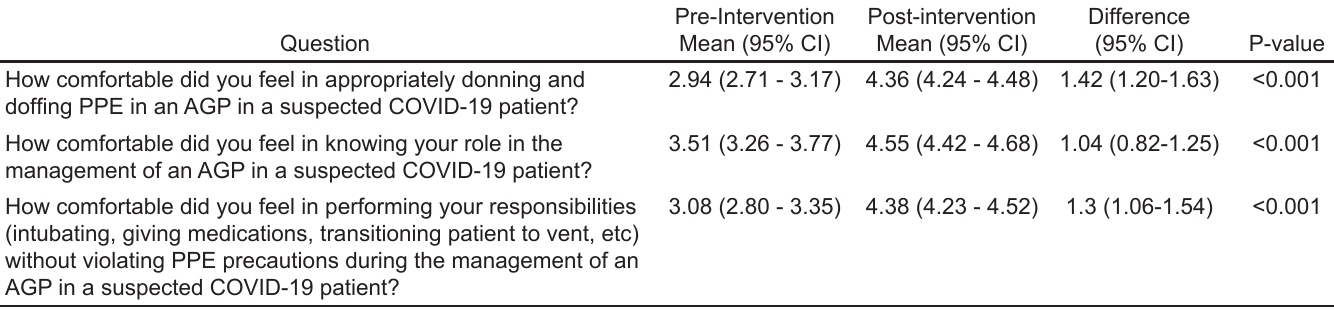
AGP, aerosol-generating procedure; PPE, personal protective equipment; CI, confidence interval.